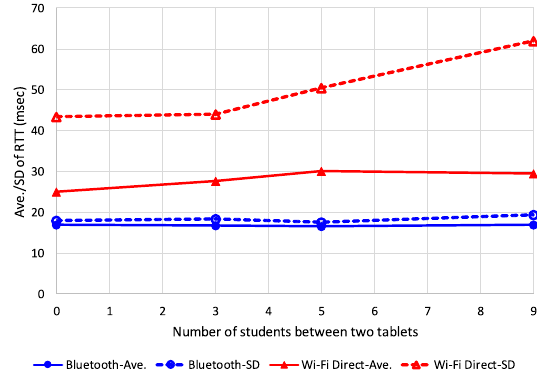
Fig. 12 Result of survey on influence of human